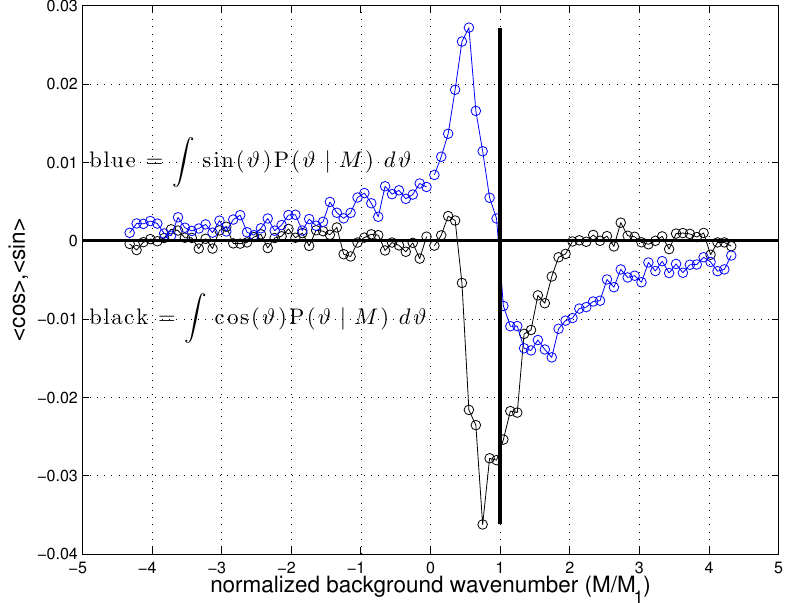
(cid:82) (cid:82) Figure 7. Drift cos ( ϑ ) ˆ p d ϑ and bound sin ( ϑ ) ˆ p d ϑ pieces of the phase locking distributions ˆ p for e o / e GM = 1 × 10 − 2 . The drift terms implies a mean transport of higher vertical wavenumber and energy exchange between test wave and background. The background wavenumber is normalized by the nominal resonant